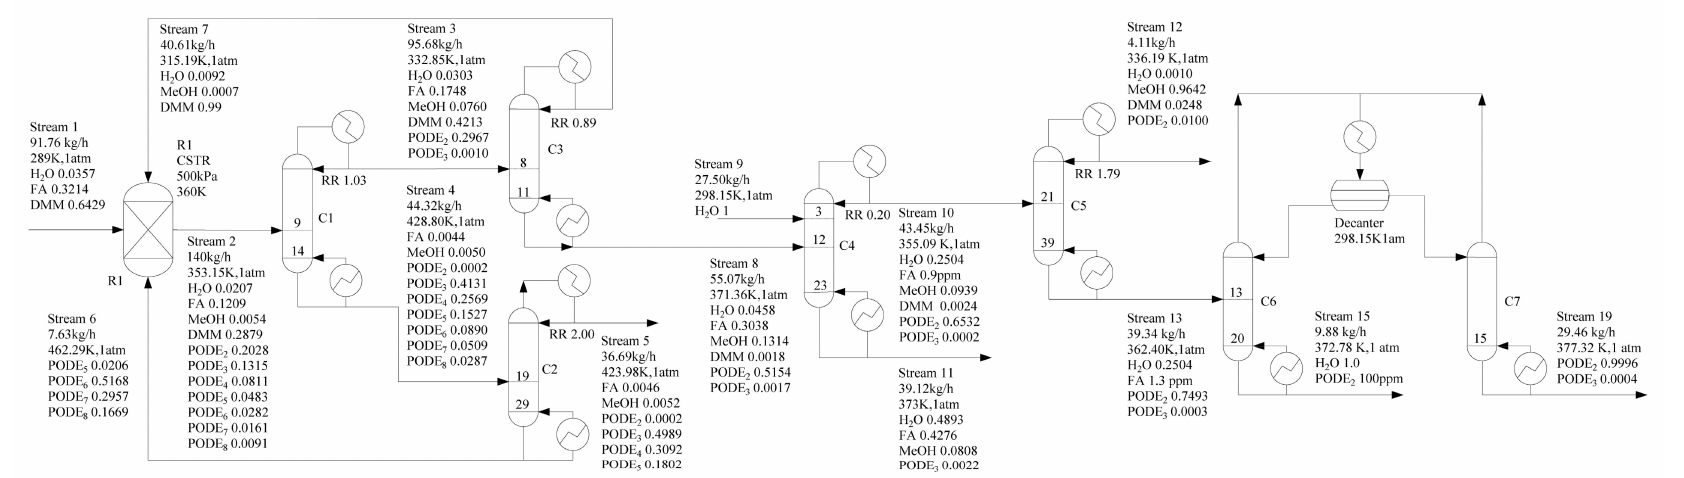
Figure 4. Optimized process design flowsheet (mass